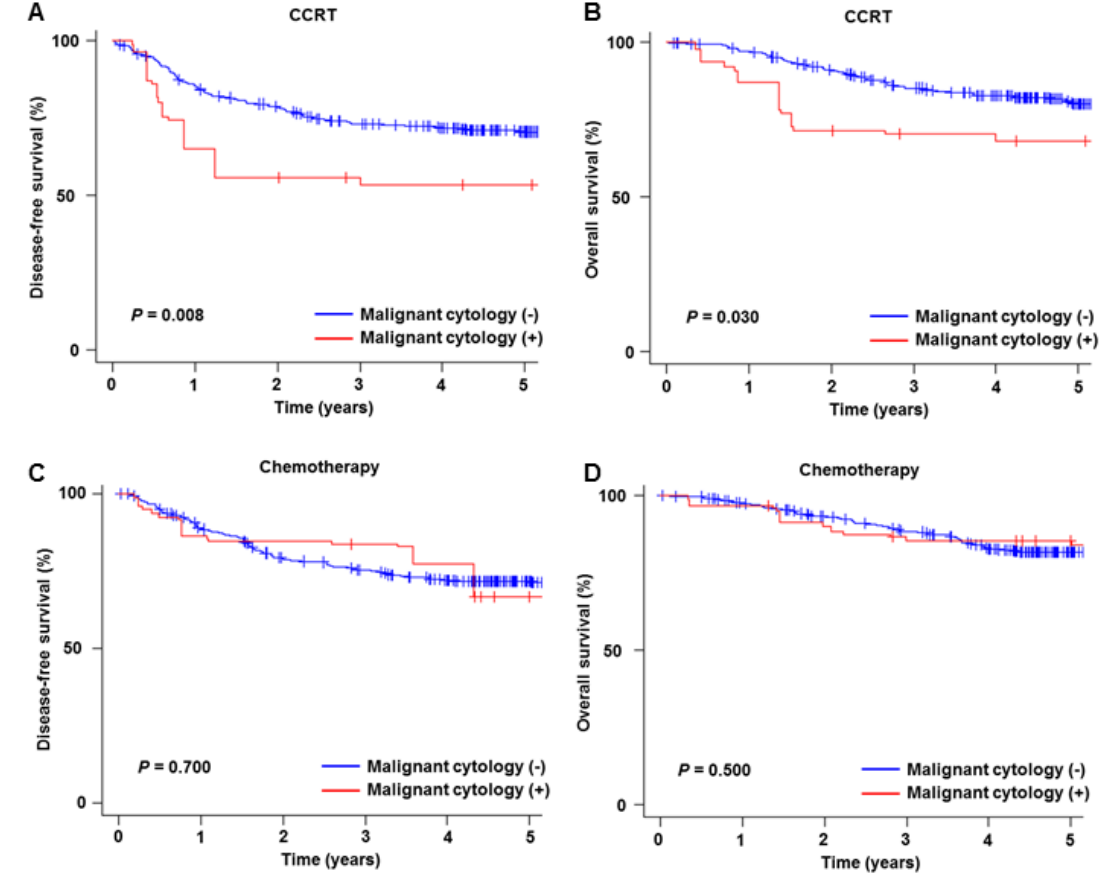
Figure 5. Survival outcome based on peritoneal cytology results per postoperative treatment. Kaplan-Meier curves are shown based on the presence and absence of malignant cells in the peritoneal cytology tests for CCRT cohort (DFS for panel A , and OS for panel B ) and systemic chemotherapy cohort (DFS for panel C , and OS for panel D ). Log-rank test for P -Values on propensity score inverse provability of treatment weighting. Abbreviations: CCRT, concurrent chemo-radiotherapy; DFS, disease-free survival; and OS, overall survival.